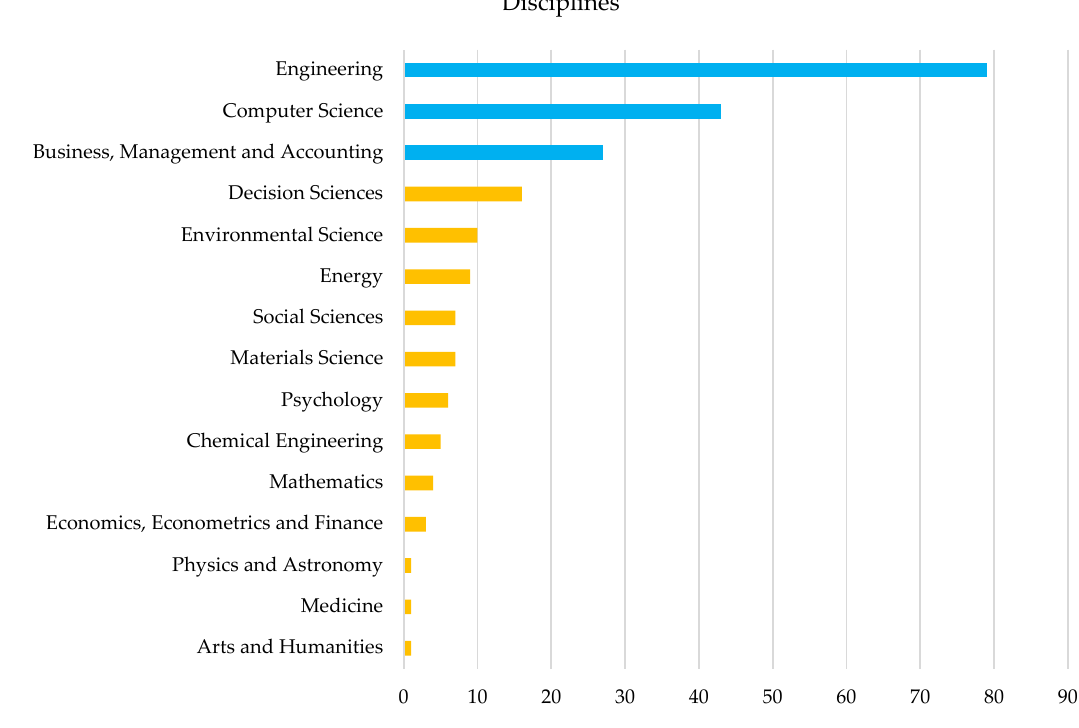
Figure 6. Top 100 Industry 4.0 articles grouped by discipline.